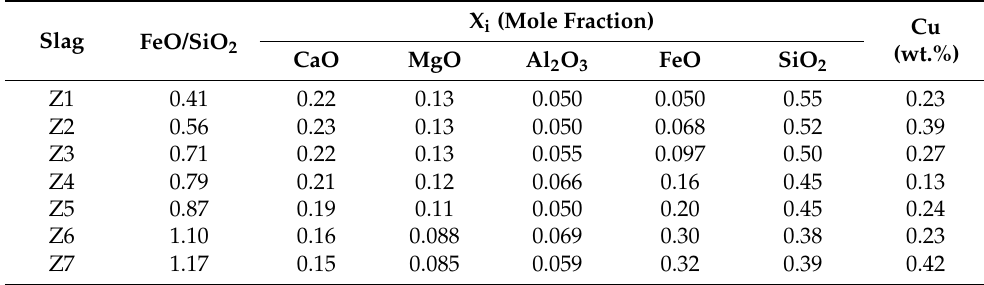
Table 1. The composition of slag samples at different FeO/SiO 2 burden ratios. Slag